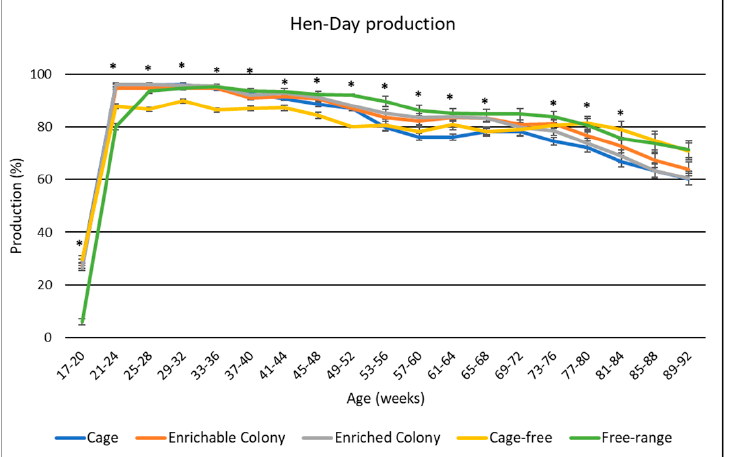
Figure 1. The effect of housing environment on hen–day production of brown egg layers by age. * Signifies a significant effect ( p < 0.05) of housing environment during that age range.